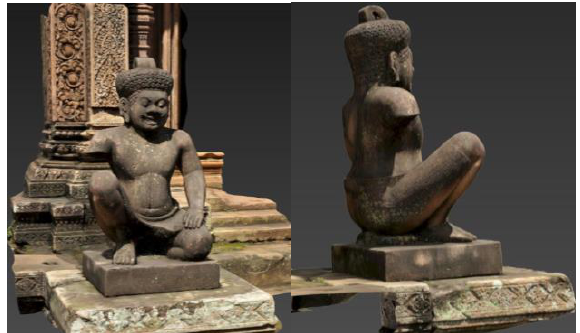
Figure 14. The 3D model of the statue from different views 4.1.5